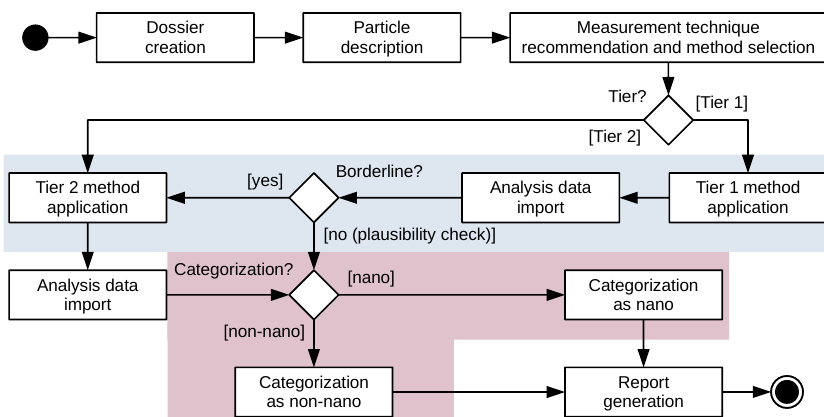
Figure 5. Simplified representation of the guided workflow in the NanoDefiner e-tool, highlighting Tier 1 to Tier 2 escalation in case of a borderline material (blue), and the final categorization step (purple).